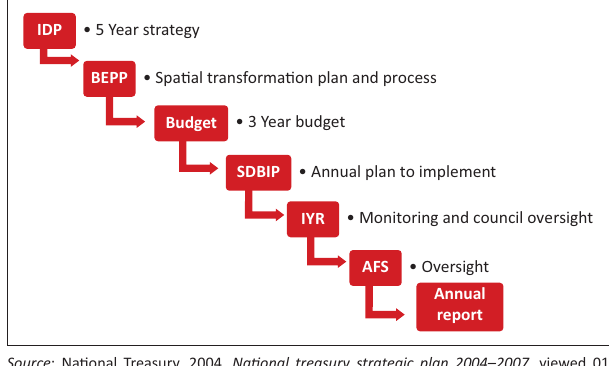
FIGURE 1: Local government accountability